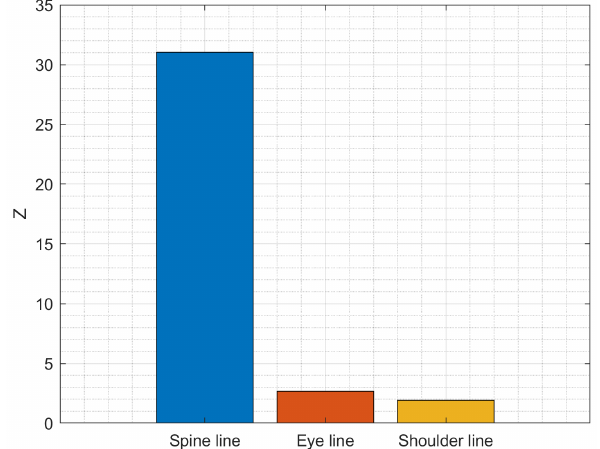
Figure 19. Importance of symptoms in predicting the condition of the subject (Healthy vs. Patient). Using the horizontal deviation of the spine line versus the vertical deviation of the shoulder line, a good separation can be observed between normal (healthy) subjects and diseased subjects (Figure